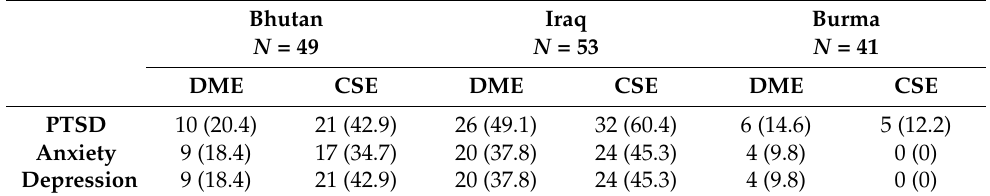
Table 3. Diagnostic proxy number (%) by country of origin at DME (T1) and CSE (T2).